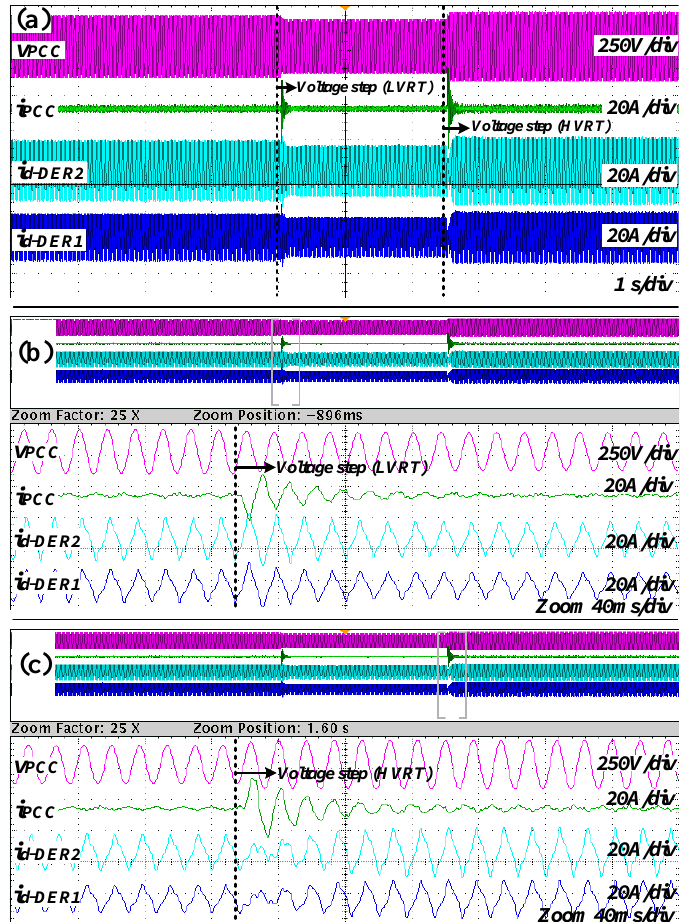
Figure 13. Experiments of the GCBC coordination considering voltage ride-through capabilities. ( a ) Steady-state view of voltage steps; ( b ) zoom-in view of a negative step in grid voltage; and ( c ) zoom-in view of a positive step in grid voltage. From top to bottom: PCC voltage and current, d-DER 2 and d-DER 1